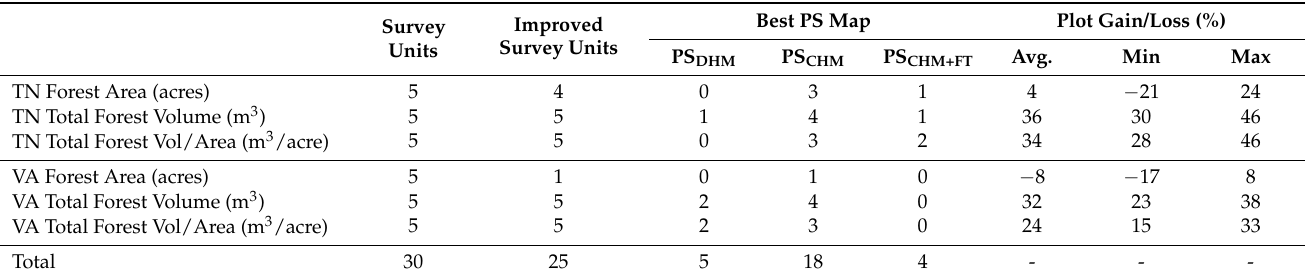
Table 5. Summary of post-stratification results by survey